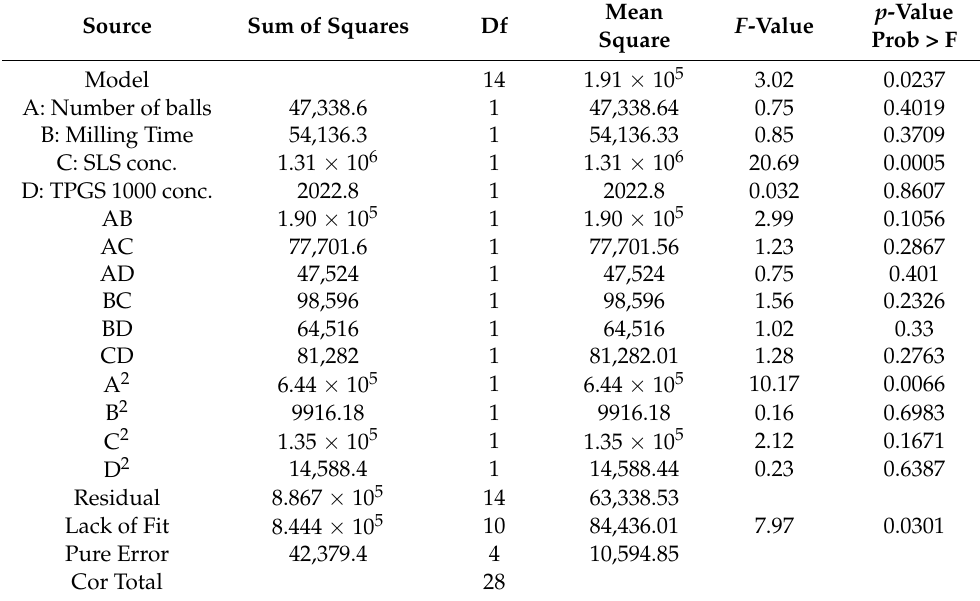
Table 4. ANOVA data for the response surface quadratic model for PS.